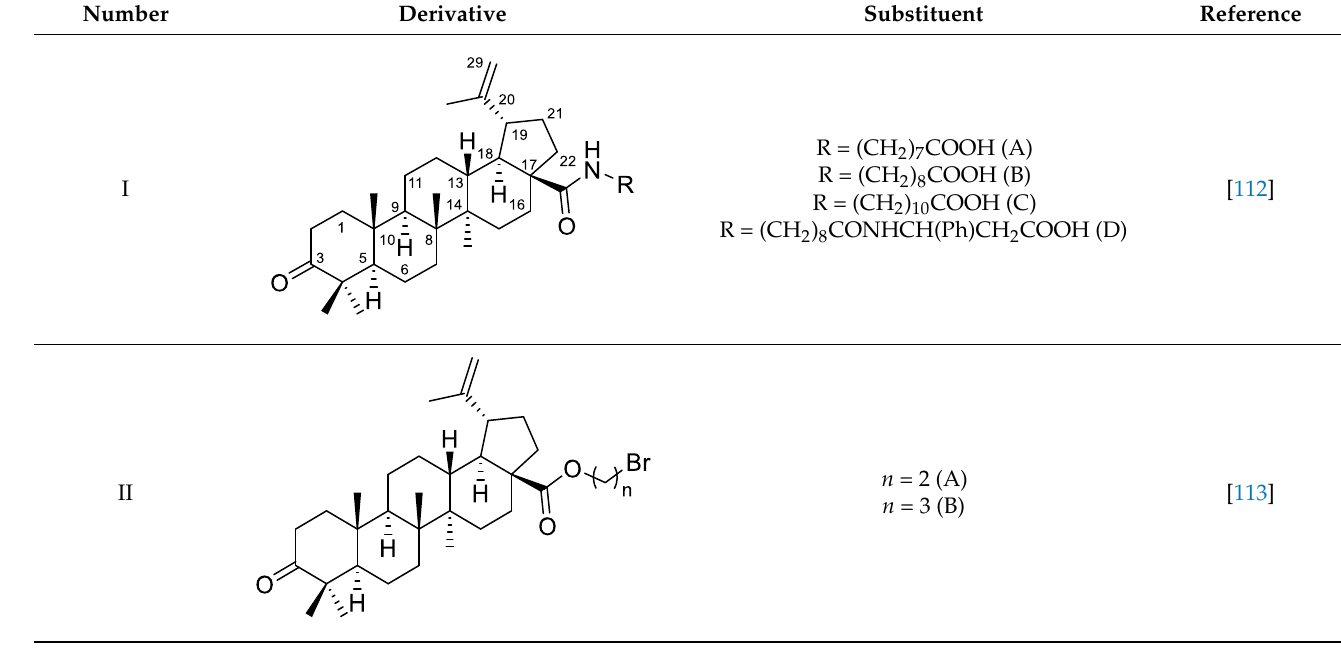
Table 1. Betulonic acid derivatives.